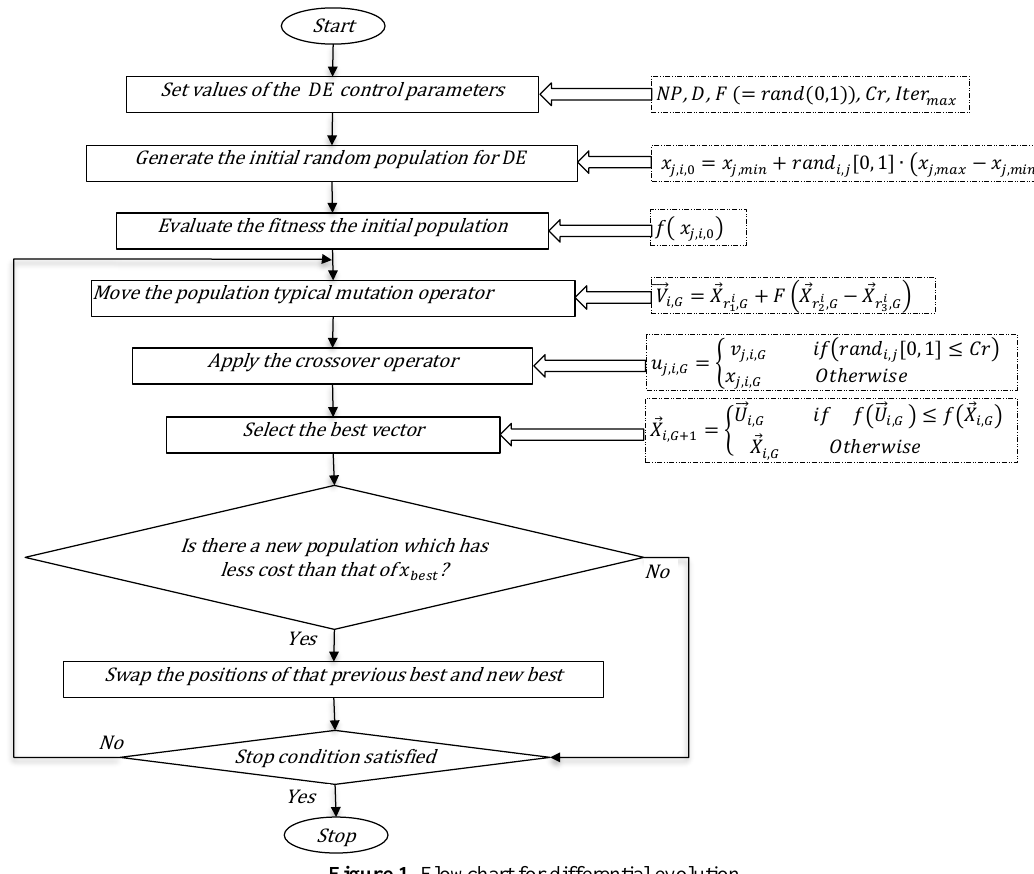
Figure 1. Flowchart for differential